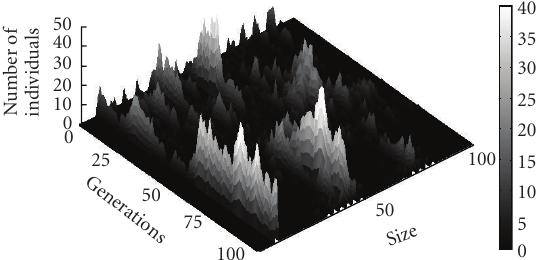
Figure 21: Parameter optimization Experiment 2: chromosome size in the population.